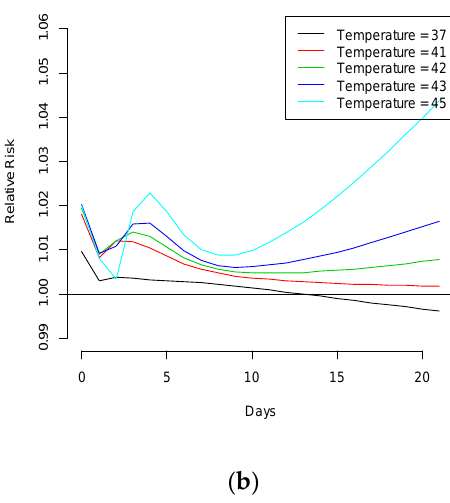
Figure 1. ( a ) Three-dimensional graphs of the relative risk (RR) of preterm birth to the exposure of maximum temperature and ( b ) RR of preterm birth to the exposure of maximum temperatures (median, P90, P95, P99 and maximum temperature recorded during the summer periods in 1986–2013). The median maximum temperature value of 30 °C is used as a reference and lags up to 21 days are plotted.